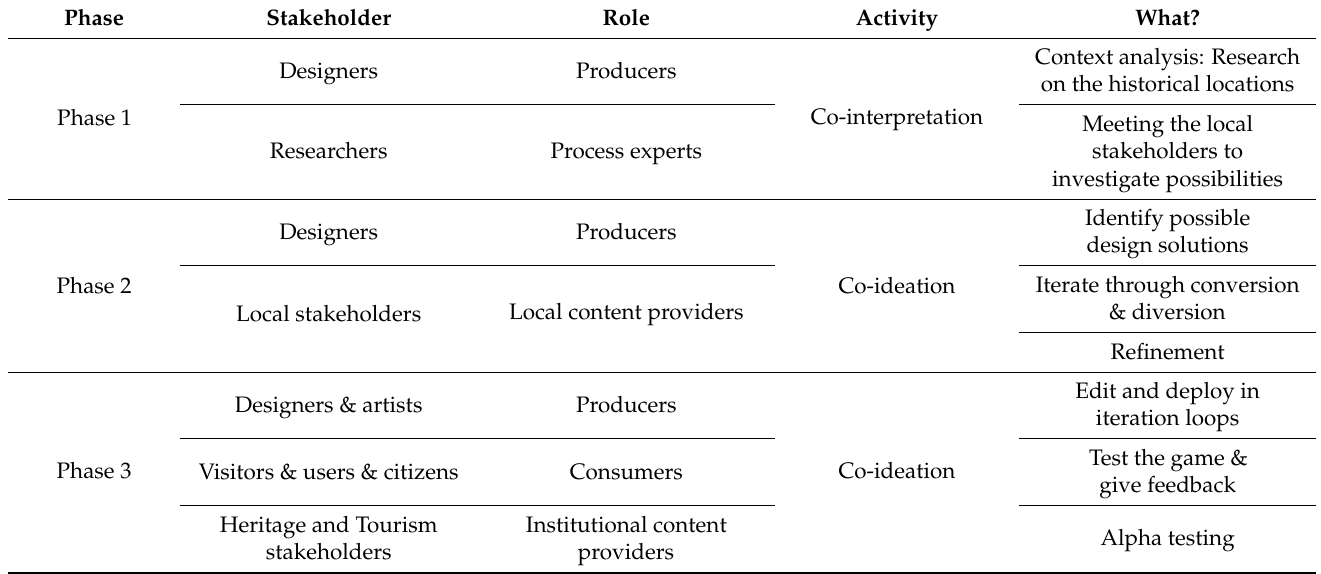
Figure 1. Victor Balaguer Museum with its motto ‘Surge et Ambula’ on the top of the main entrance, which is used as the logo of the game. Table 2. Contributors to the development of Agency of